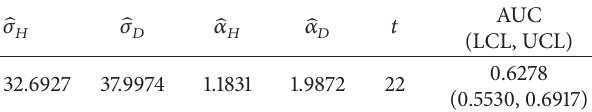
Table 2: Results for SAPS III using GHROC curve methodology.